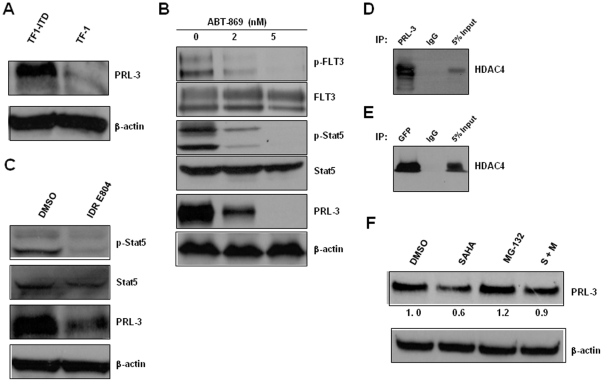
The association of PRL-3 and FLT3-ITD in AML.(A) Western blot assessment of PRL-3 protein in two isogenic cell lines, TF-1 and TF1-ITD. β-actin was used as loading control. (B) TF1-ITD cells were treated with DMSO, ABT-869 2 nM and 5 nM for 48 hours, and then followed by IP and Western blot analysis as described in Fig. 4.A. (C) MOLM-14 cells were treated with DMSO control or IDR E804 100 nM for 48 h. The cells were then lysed, and analysed by immunoblotting using anti-p-Stat5, anti-Stat5, anti-PRL-3 clone 318 and anti-β-actin. (D) MOLM-14 cell lysate was immunoprecipitated with anti-PRL-3 or anti-IgG antibody. The immunoprecipitates were immunoblotted with anti-HDAC4 antibody. (E) DLD-1-GFP-hPRL3 cell lysate was immunoprecipitated with anti-GFP or ant-IgG antibody, followed by immunoblotting analysis with anti-HDAC4 antibody. Total cellular extracts (inputs) were used as positive controls. (F) Western blot analysis of cell lysates extracted from MOLM-14 cells treated with DMSO, SAHA 4 µM, MG-132 10 µM or SAHA plus MG-132. The incubation duration of DMSO and SAHA was 24 h and MG-132 was added 4 h before harvest of cells. Densitometric analysis was performed using Amersham Image Scanner with LabScan ImageQuant TL Software. The level of PRL-3 was normalized with each β-actin level.